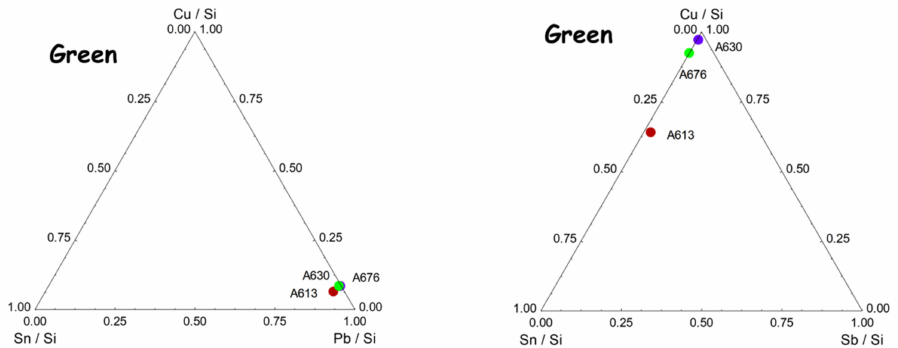
Figure 14. Comparison of the net number of photons of the elements Cu, Sn, and Pb ( left ) and Cu, Sn, and Sb ( right ) measured in the green areas. Data are normalized by Si